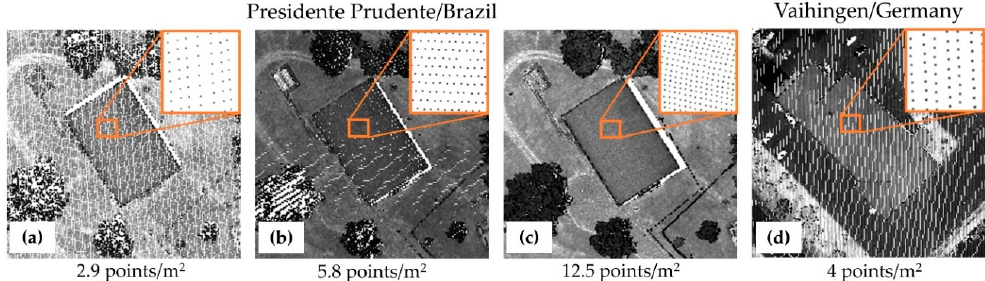
Figure 6. Presidente Prudente / Brazil dataset: 2.9 points / m 2 ( a ), 5.8 points / m 2 ( b ), and 12.5 points / m 2 ( c ). Vaihingen / Germany dataset ( d ).